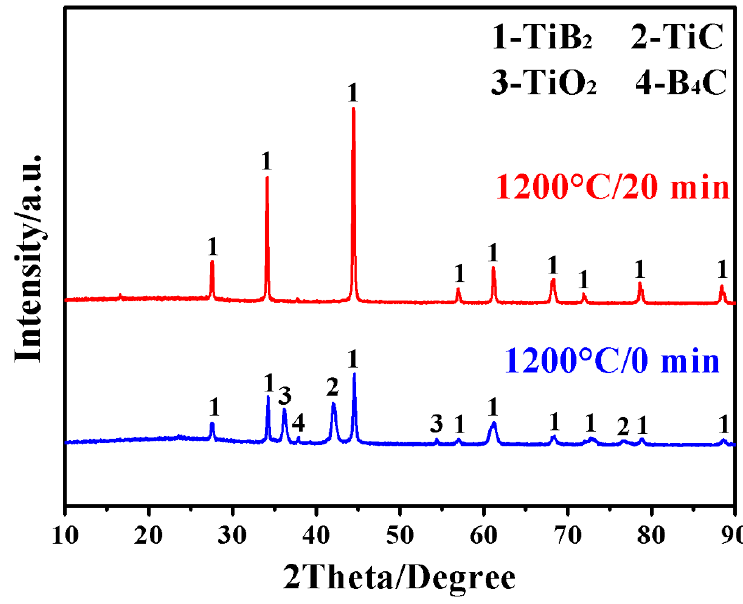
Figure 2. Phase formation in samples after MSM-BCTR treatments at 1200 °C for 0 and 20 min, respectively.